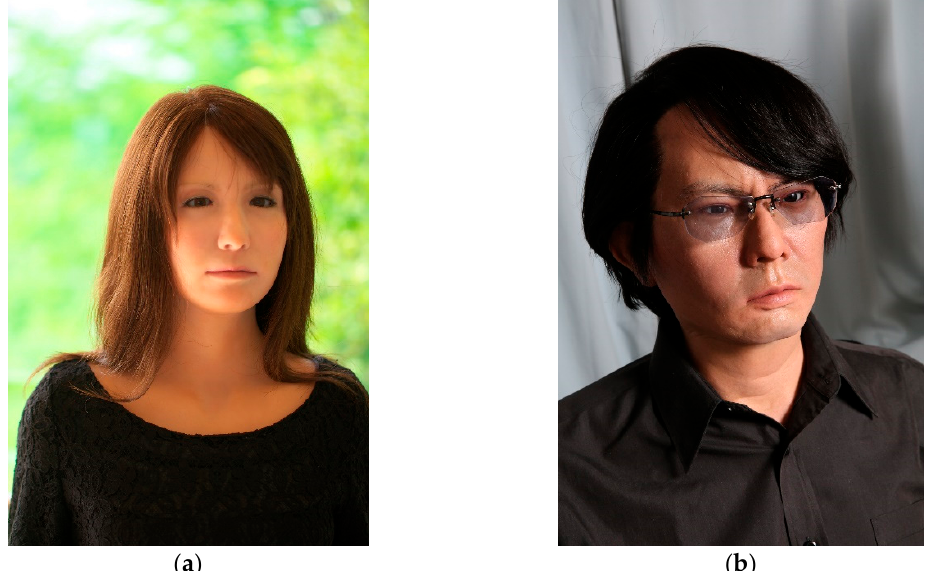
Figure 2. Appearance of Geminoids: ( a ) Geminoid F: female android; ( b ) Geminoid HI4: male android.